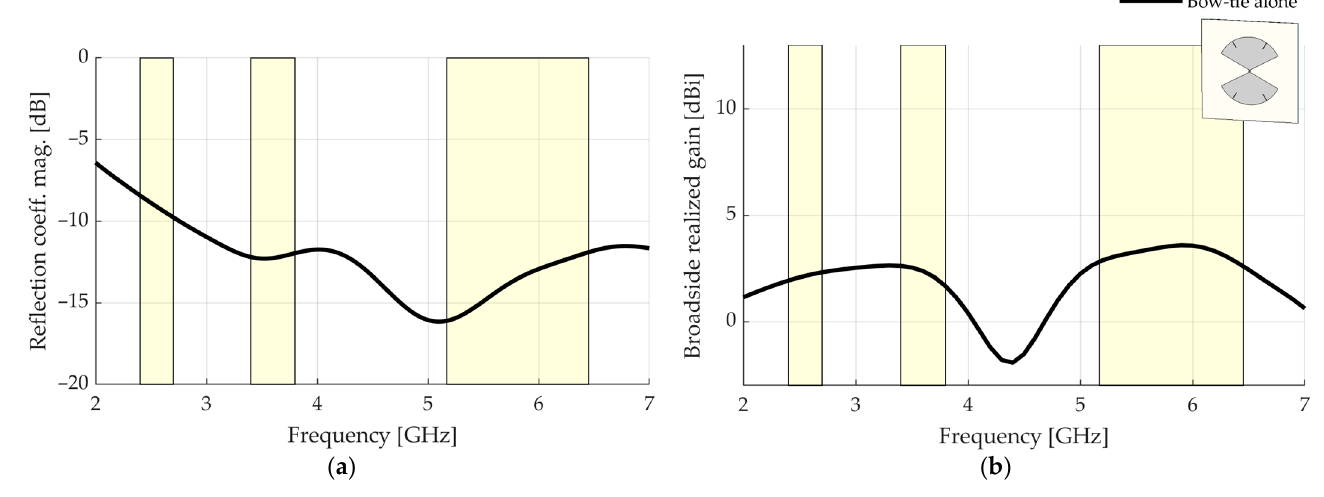
Figure 7. Simulated results for the standalone antenna (without any reflector): ( a ) reflection coefficient magnitude; ( b ) broadside realized gain. The bands of interest are highlighted.